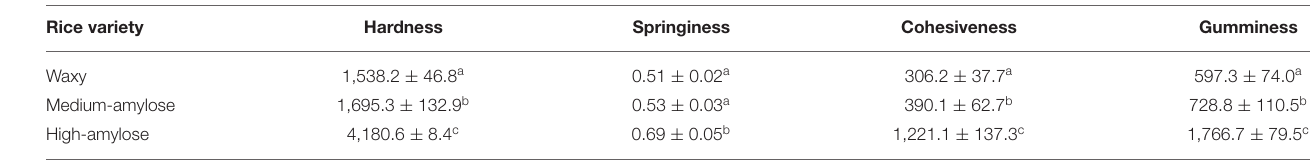
TABLE 4 | Texture attributes of cooked parboiled black rice with different amylose contents